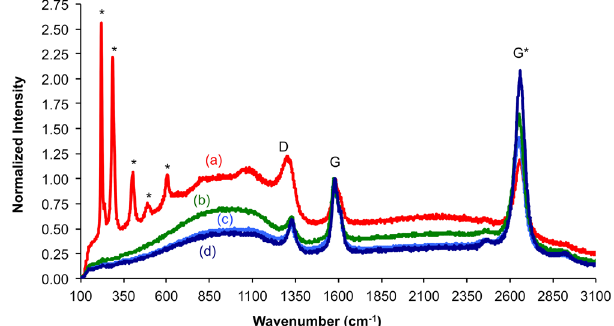
Figure 2. Raman spectra of the quartz wool supported-CNTs. Normalized Raman intensity (633 nm) of ( a ) as grown quartz wool supported CNTs showing peaks ( * ) due to iron oxide catalyst residue, which are removed after wet air oxidation/acid wash ( b ). The G:D ratio decreases upon epoxidation ( c ) due to functionalization of the CNT side walls, while adsorption of Cd 2 + does not significantly effect the spectra ( d ), suggesting that adsorption occurs predominantly via the epoxide oxygen, rather than the CNT sidewall.